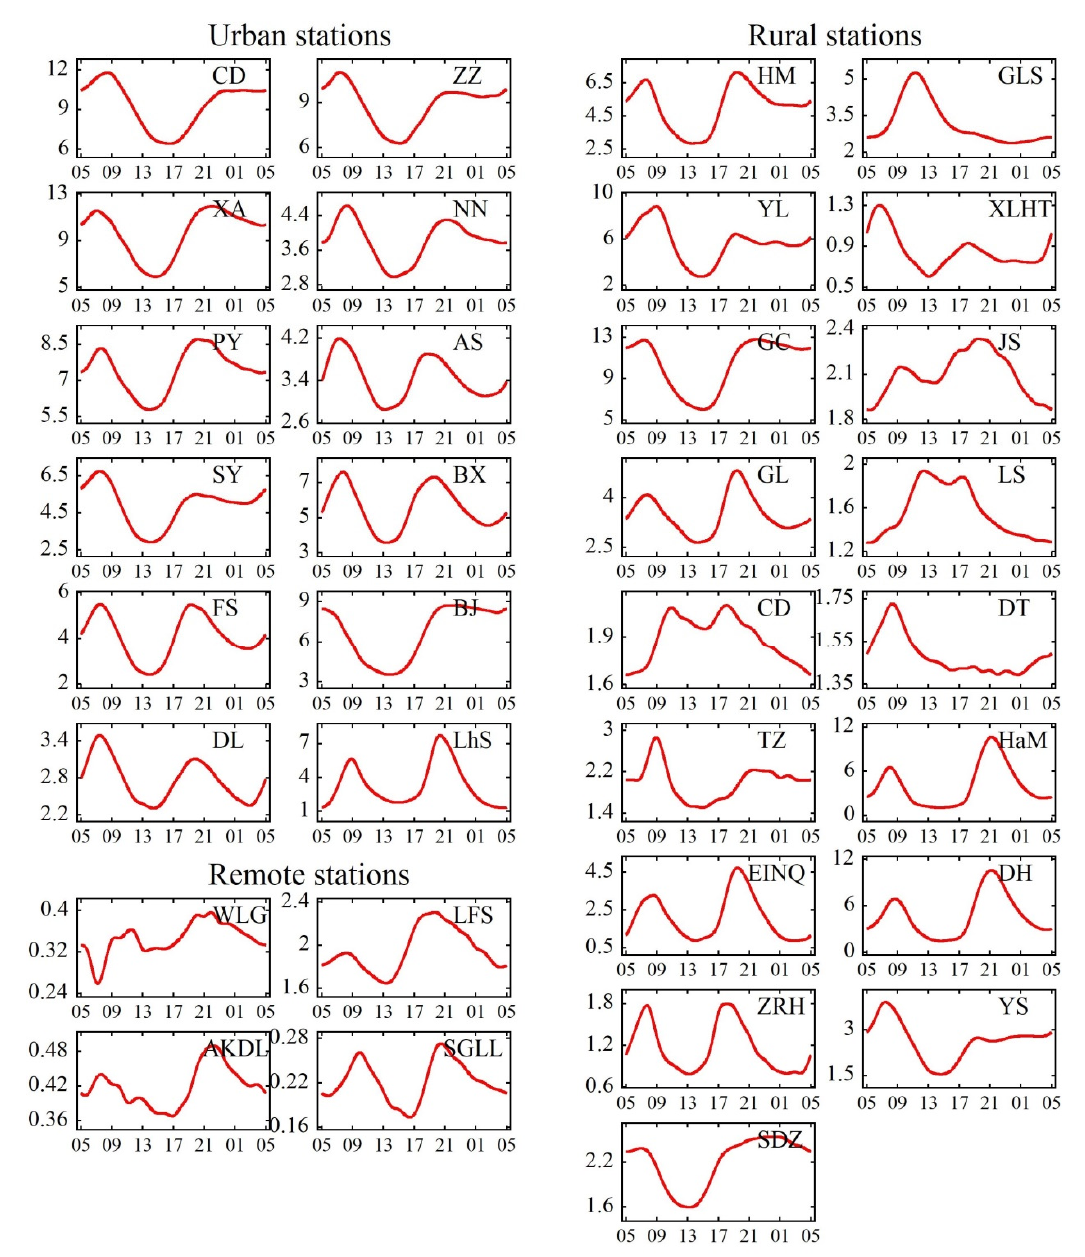
Figure 8. The diurnal variation of BC concentration at each station, units: µ g m − 3 .